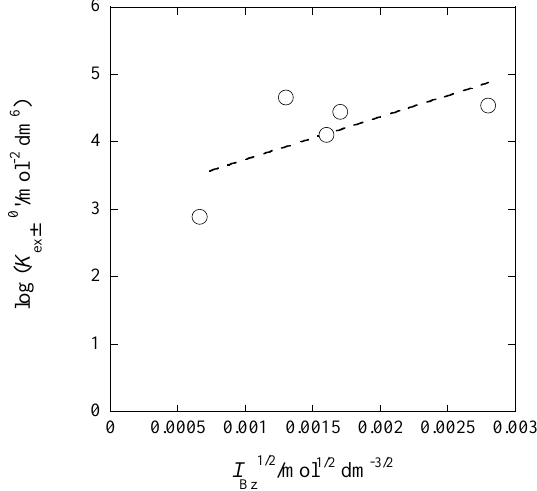
Figure 8. Plot of log K ex±0 ′ versus I Bz1/2 based on Equation (16) for the Pb(II) extraction with Cd(NO 3 ) 2 and B18C6 into Bz. The symbol K ex±0 ′ was defined as K ex± / y Pb ( y Pic ) 2 .